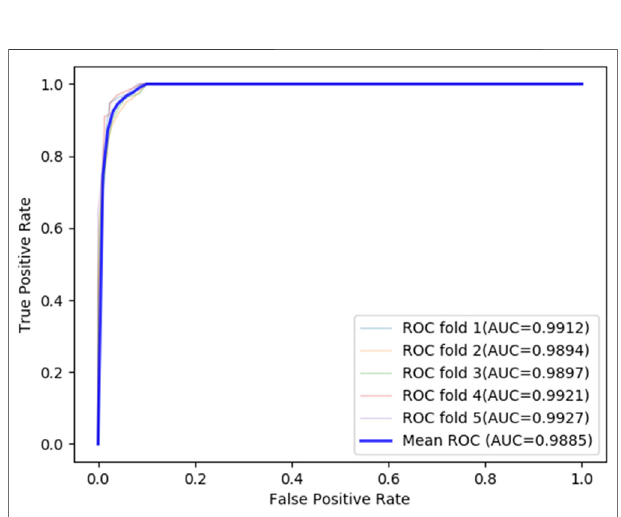
FIGURE 4 | ROC curves of LDA-EAGCN in different situations of 5-fold cross-validation.